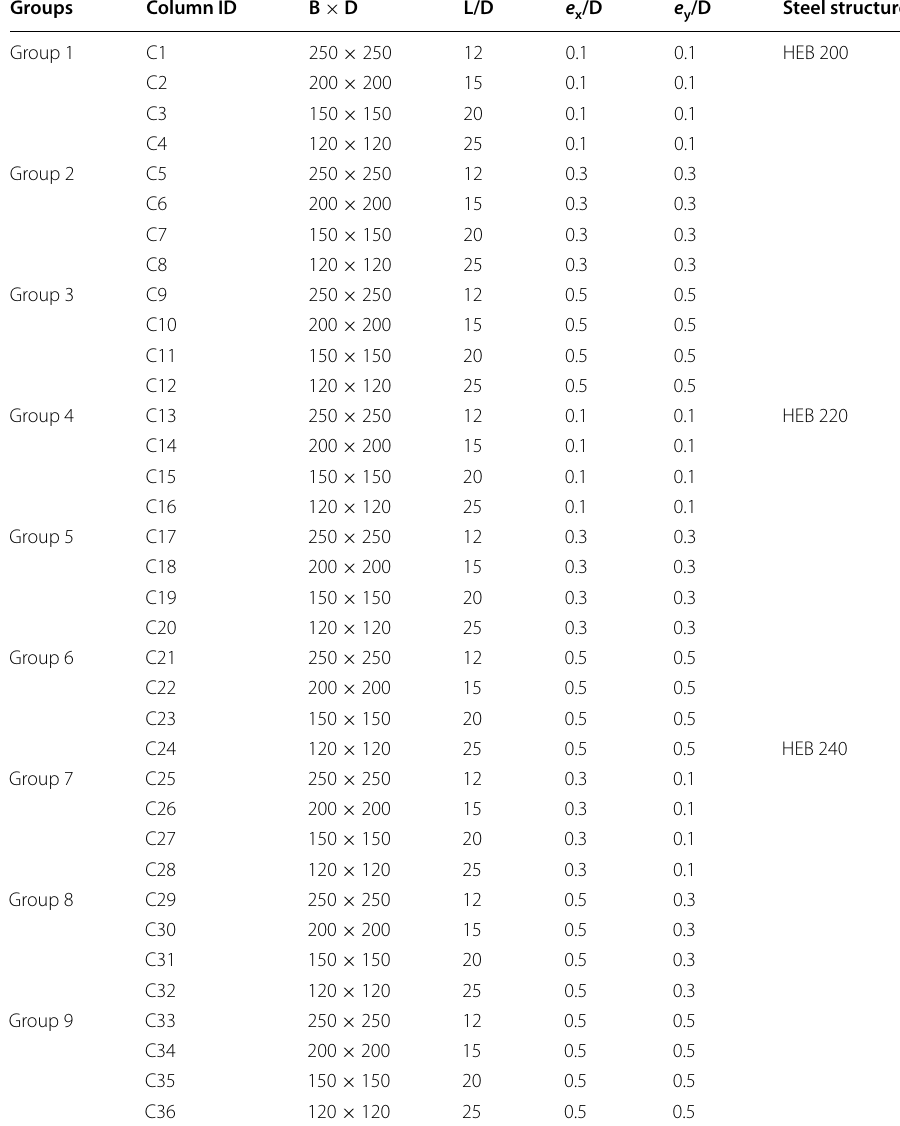
Table 1 Specifications for different column specimen